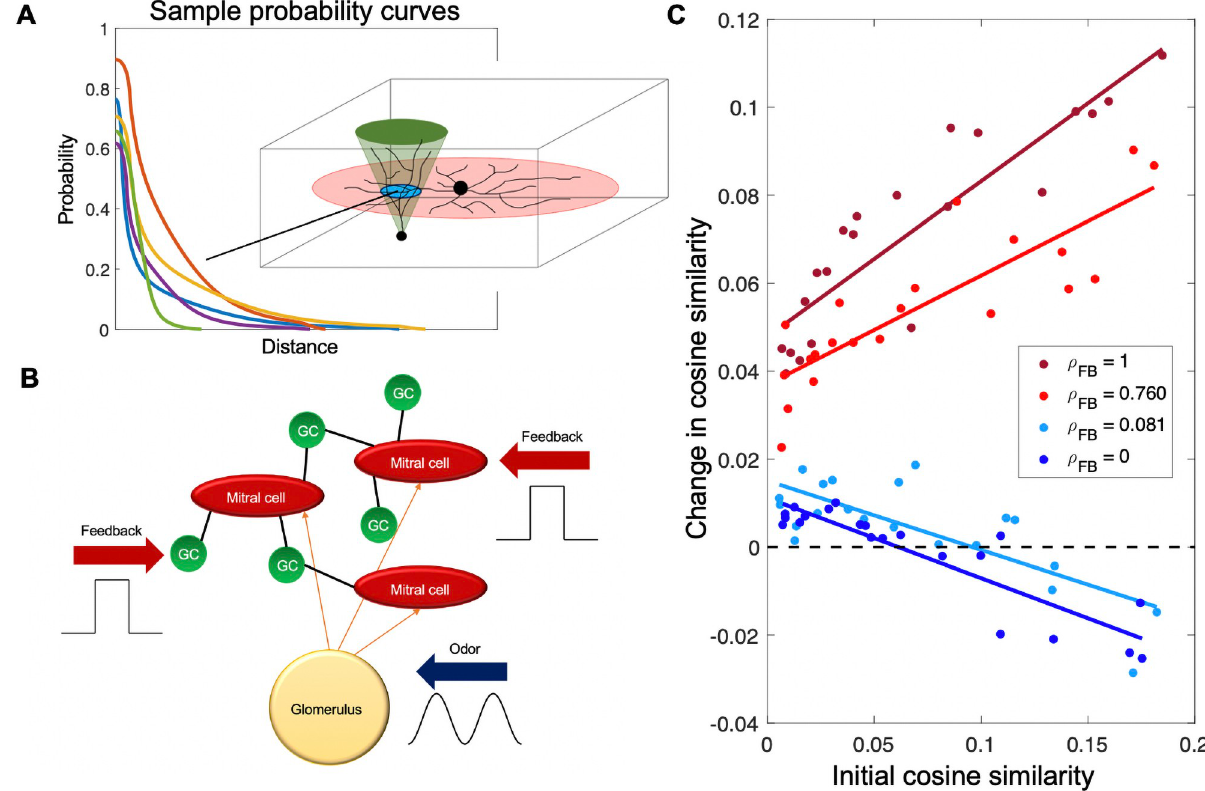
Fig 4. A mechanistic model produces trends in pattern convergence and divergence similar to those predicted by the statistical framework. ( A ) The probability of connection is a function of the overlap of the mitral cell and granule cell dendritic trees, here represented as a disc and cone, respectively. Different parameters in the mean-field distributions of these dendritic trees produce different probability curves for any given MC-GC pair. ( B ) The algorithm in (A) is used to generate a network of MCs interconnected by GCs. Network dynamics are simulated via the Izhikevich model [63, 64], with each neuron in the network receiving external inputs in the form of odor or feedback as well as reciprocal inputs resulting from the connectivity of the network. Odor input is modeled as an oscillatory current to mimic the respiratory cycle while external feedback is modeled via a constant current input pulse. ( C ) For high cortical thresholds, the cosine similarity between odor representations increases (pattern convergence) or decreases (pattern divergence) linearly in the initial similarity, according to the correlation in the feedback inputs. In (C), we simulated 10,000 MCs grouped into 500 glomeruli and 100,000 cortical cells, each sampling 7% of the MCs, with odor targeting 12% of the glomeruli, positive feedback targeting 8% of the MCs, and negative feedback targeting all